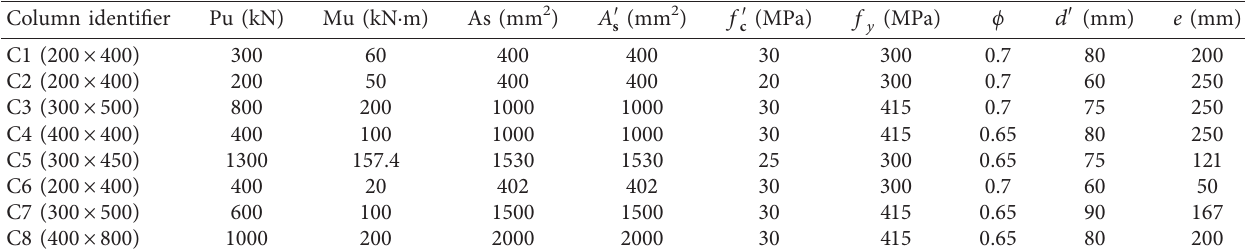
Table 1: Uniaxial column input data.